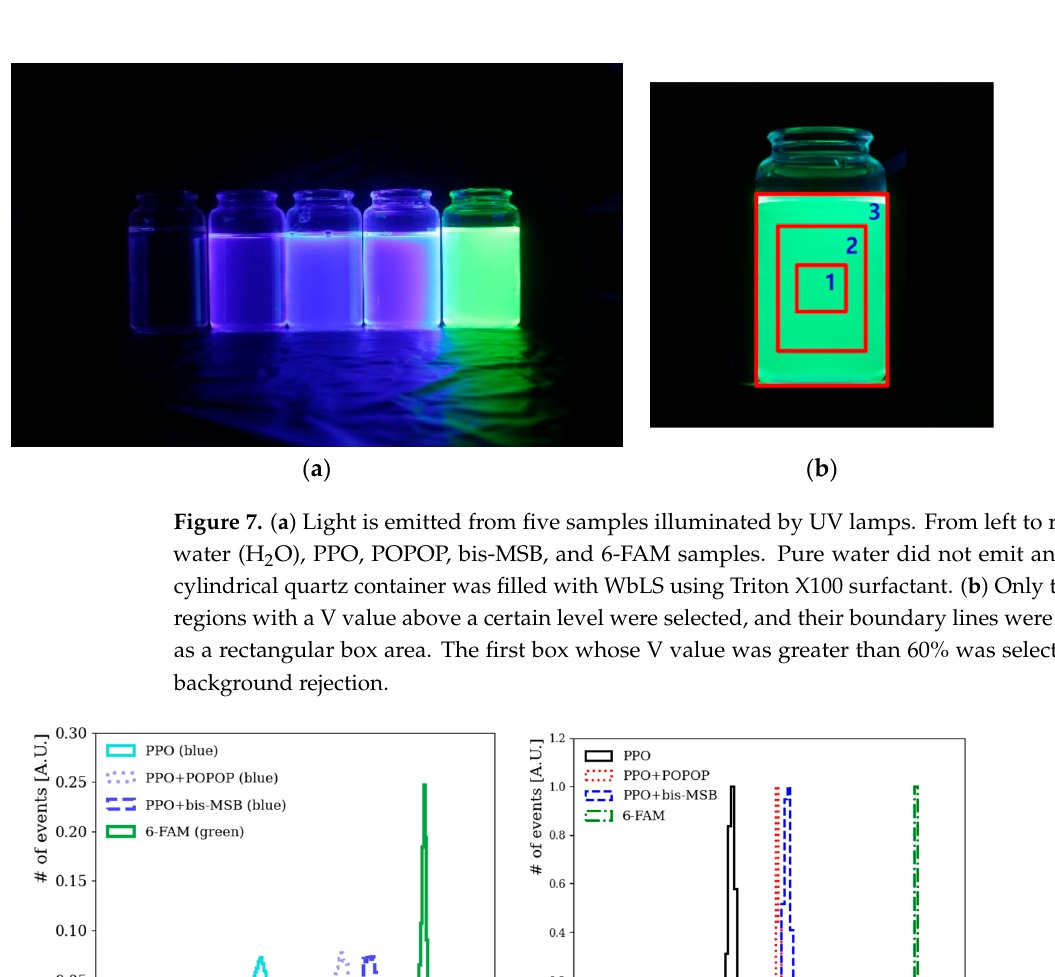
Figure 7. ( a ) Light is emitted from five samples illuminated by UV lamps. From left to right, pure water (H 2 O), PPO, POPOP, bis-MSB, and 6-FAM samples. Pure water did not emit any light. A cylindrical quartz container was filled with WbLS using Triton X100 surfactant. ( b ) Only those pixel regions with a V value above a certain level were selected, and their boundary lines were displayed as a rectangular box area. The first box whose V value was greater than 60% was selected for the background rejection.